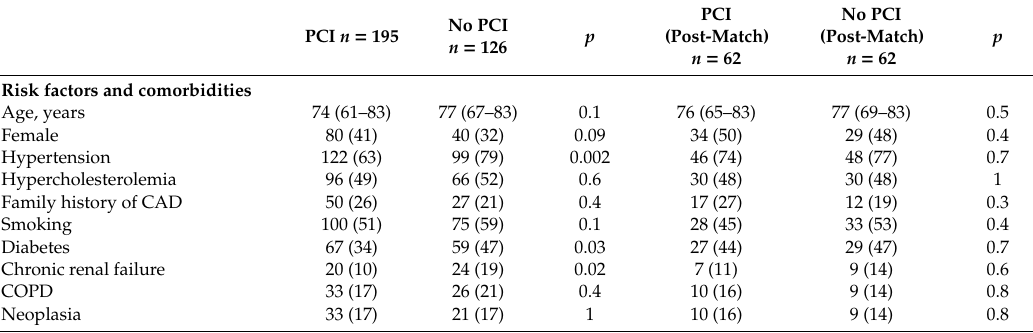
Table 1. Patient characteristics at admission ( n (%) or median (interquartile range)). PCI n =